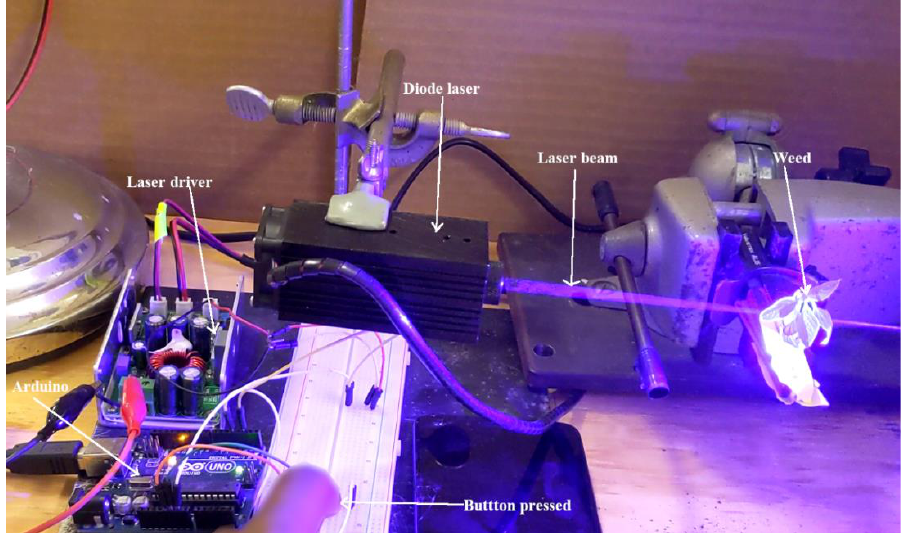
Figure 4. Laser setup to cut the weed stem